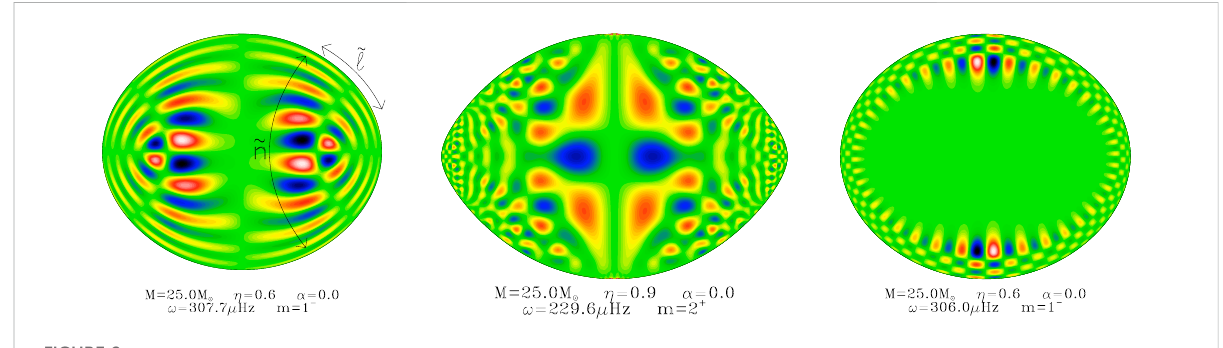
FIGURE 2 Differentclassesofacousticmodes.Lefttoright:a2-periodislandmode,achaoticmode,awhisperinggallerymode.Theshownquantityisthe Lagrangian pressure perturbation rescaled by the square root of the stellar density, δ P /